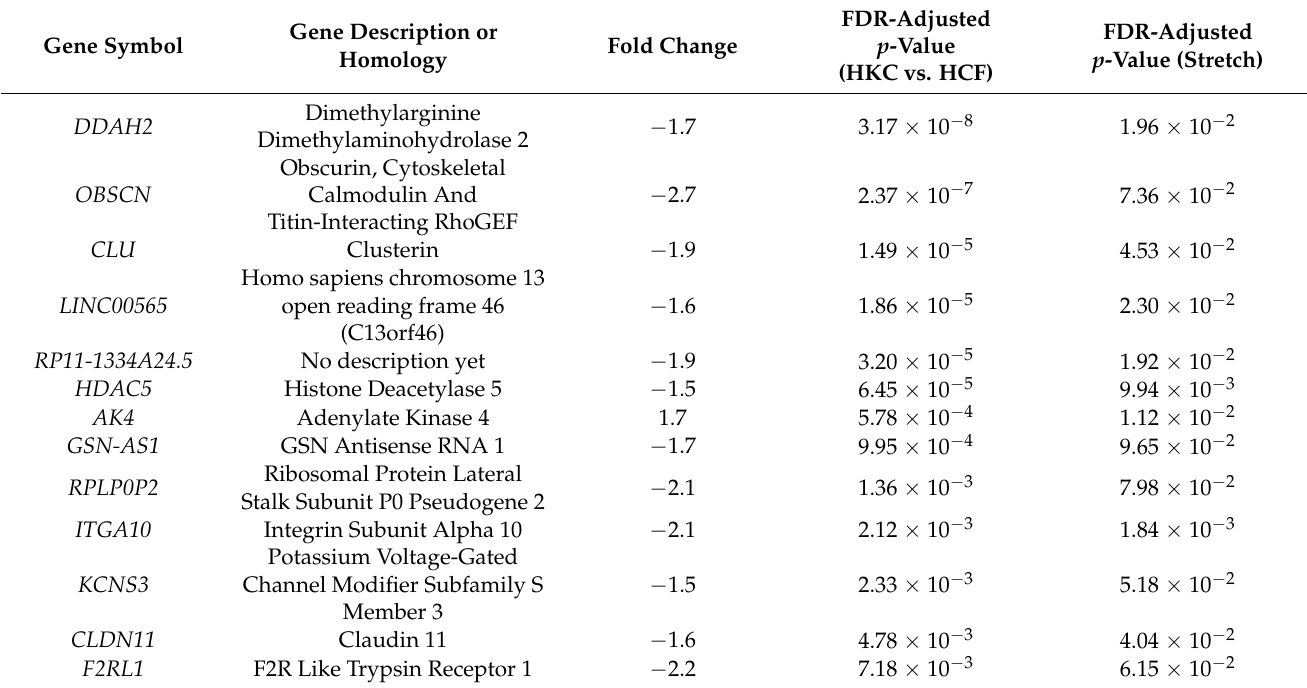
Table 4. KC-altered genes responsive to CMS.